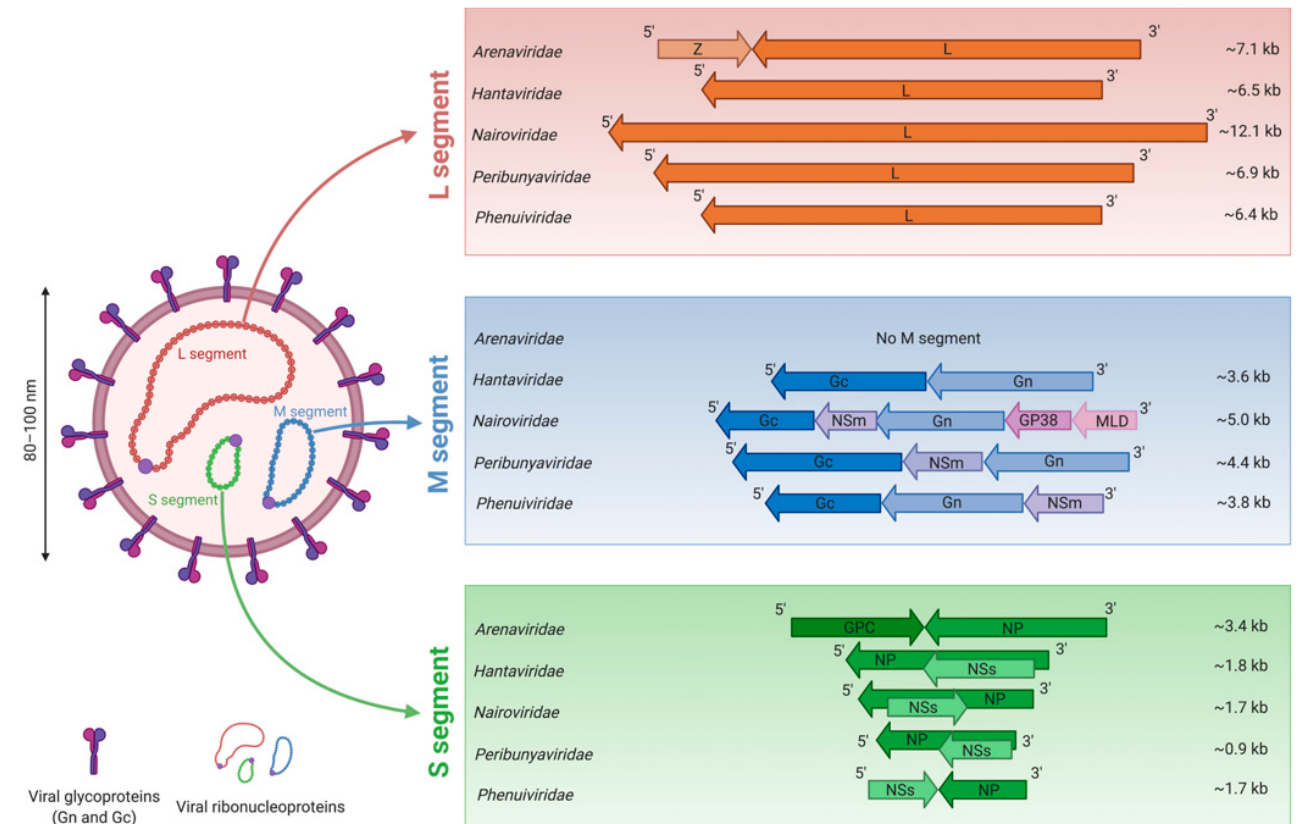
Figure 1. Schematic representation of viral genomes from the Bunyavirales order. A typical bunyaviral particle is represented on the left. The particularities of the genome from each family are represented on the right. The nucleotide lengths are displayed and based on full-length sequences available in GenBank. The viral M segment encodes a glycoprotein precursor (GPC) (not represented in the figure), which is further matured into different proteins (Gn, Gc, and sometimes NSm, MLD, GP38) that are depicted here on the viral genome. GPC: glycoproteins precursor; NP: nucleoprotein; NSm: non-structural protein M; NSs: non-structural protein S; MLD: mucin-like domain; Z: zinc-binding matrix protein.